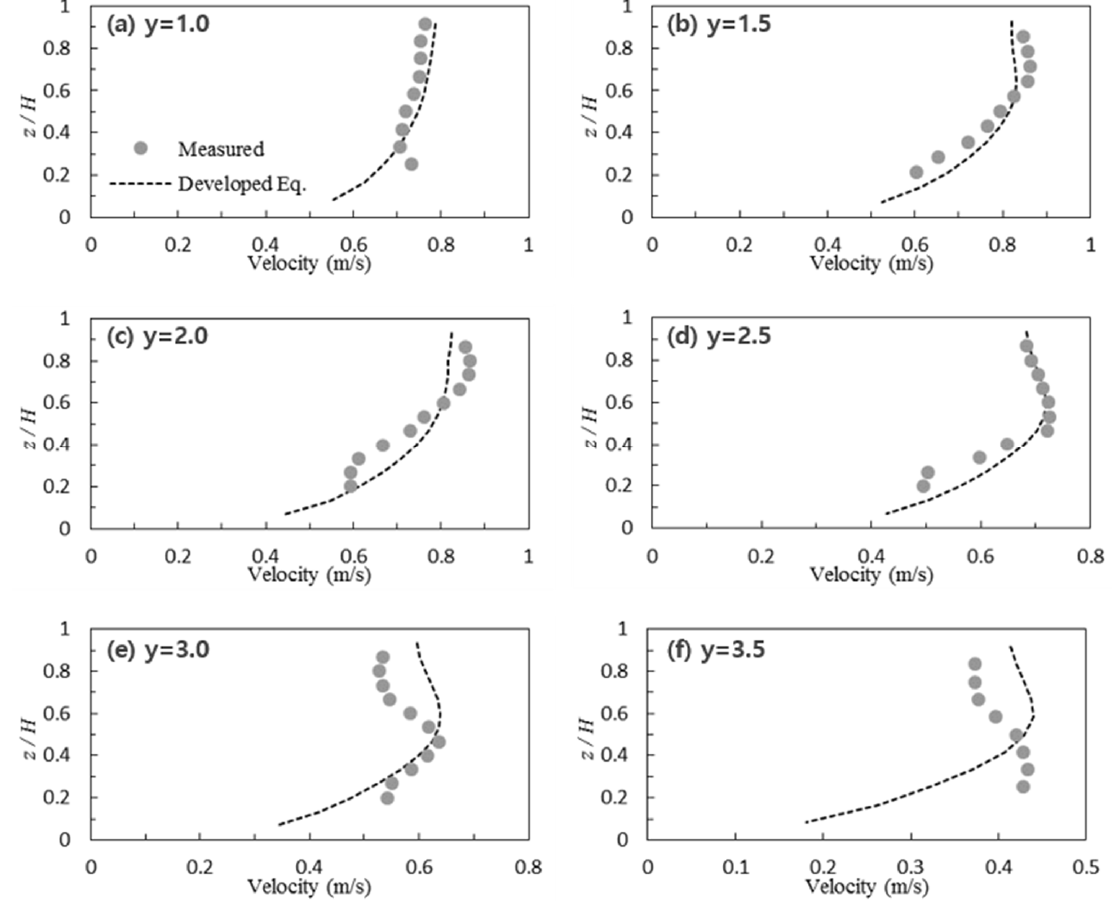
Figure 7. Comparison between measured velocity (dot) and that estimated by Equation (7) (line) at Section S4 of AMC 315 in nature-like channel (y denotes lateral coordinate from left to right bank).